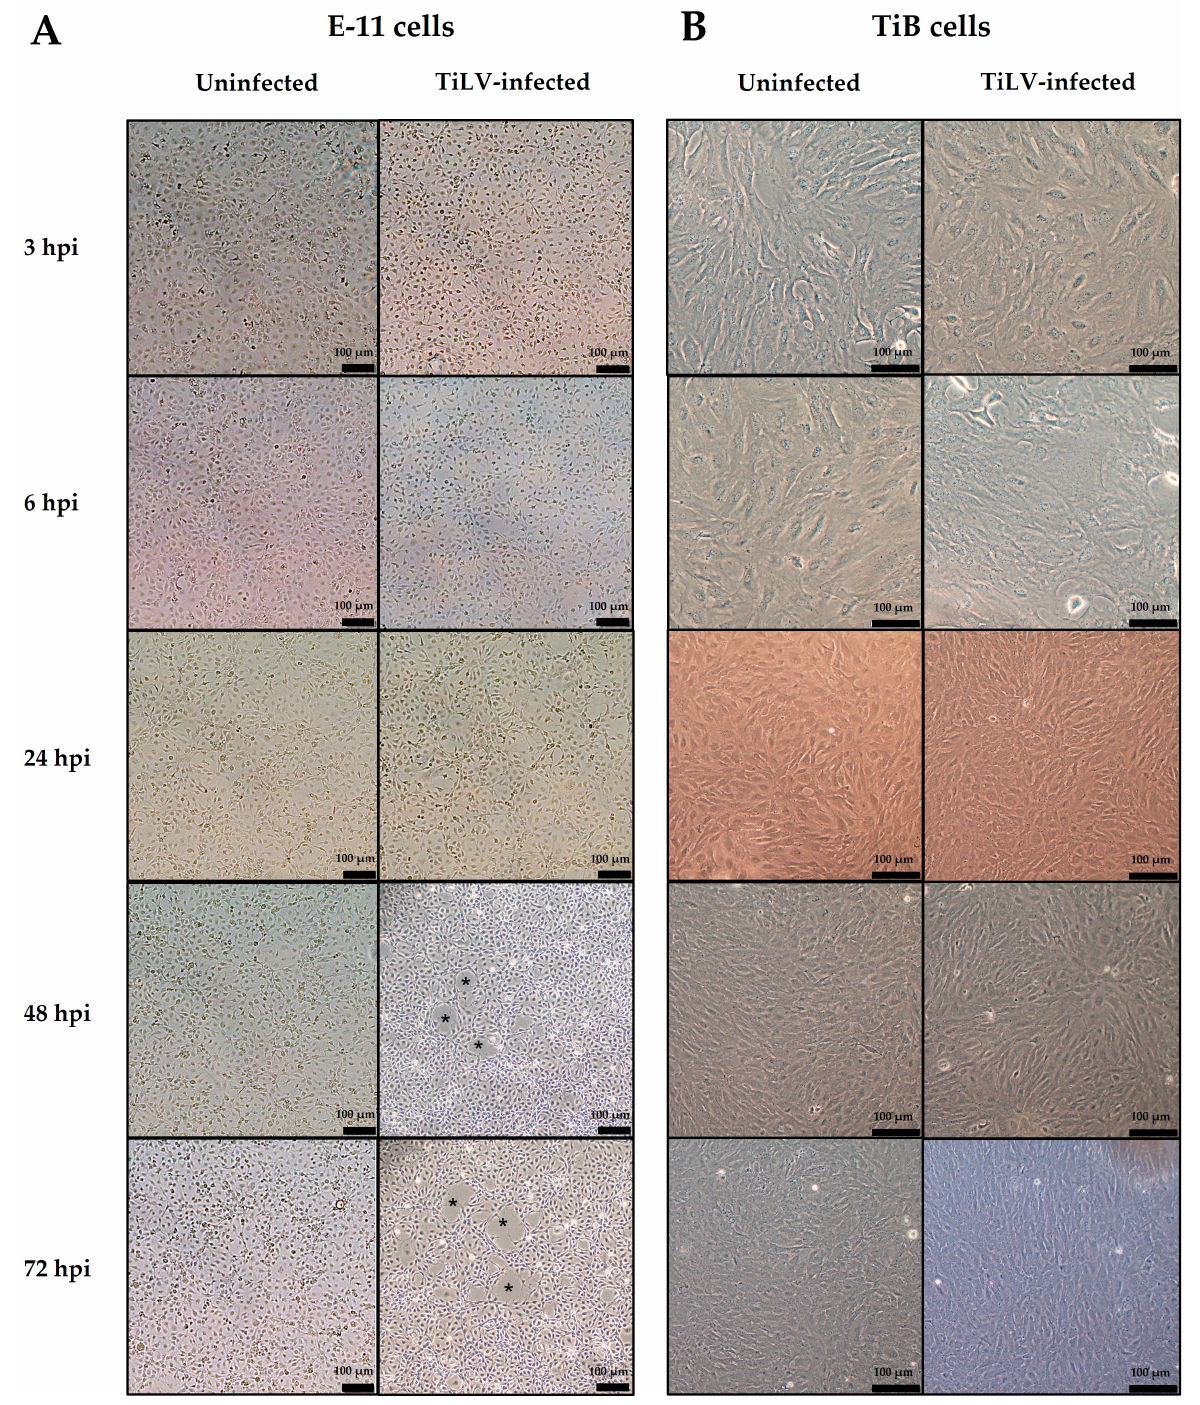
Figure 1. Representative figures of uninfected and tilapia lake virus (TiLV)-infected cells at different time points post-infection are presented in ( A ) the E-11 cells and ( B ) TiB cells. TiLV induced CPE formation (asterisks) in the E-11 cells at 48 and 72 hpi, while no morphological changes were observed in the TiB cells at any of the examined time